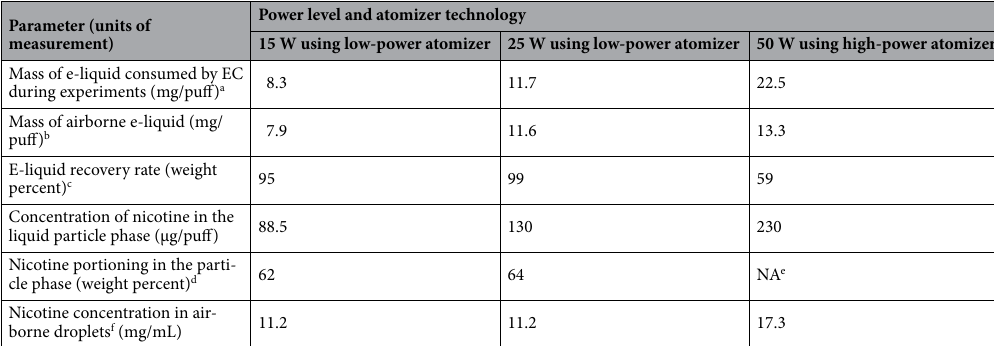
Table 2. Summary of consumption data. The recovery rate was calculated according to the e-liquid consumption that was used as a reference. DLPI DEKATI low pressure impactor, EC electronic cigarette, µg